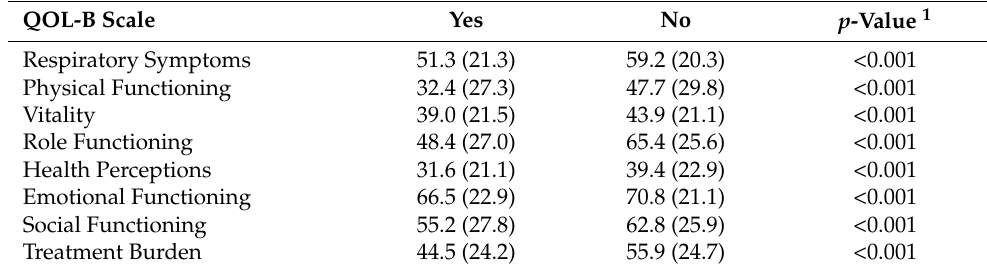
Table 4. Discrimination of QOL-B scores, stratified by history of prior hospitalization in the previous 12